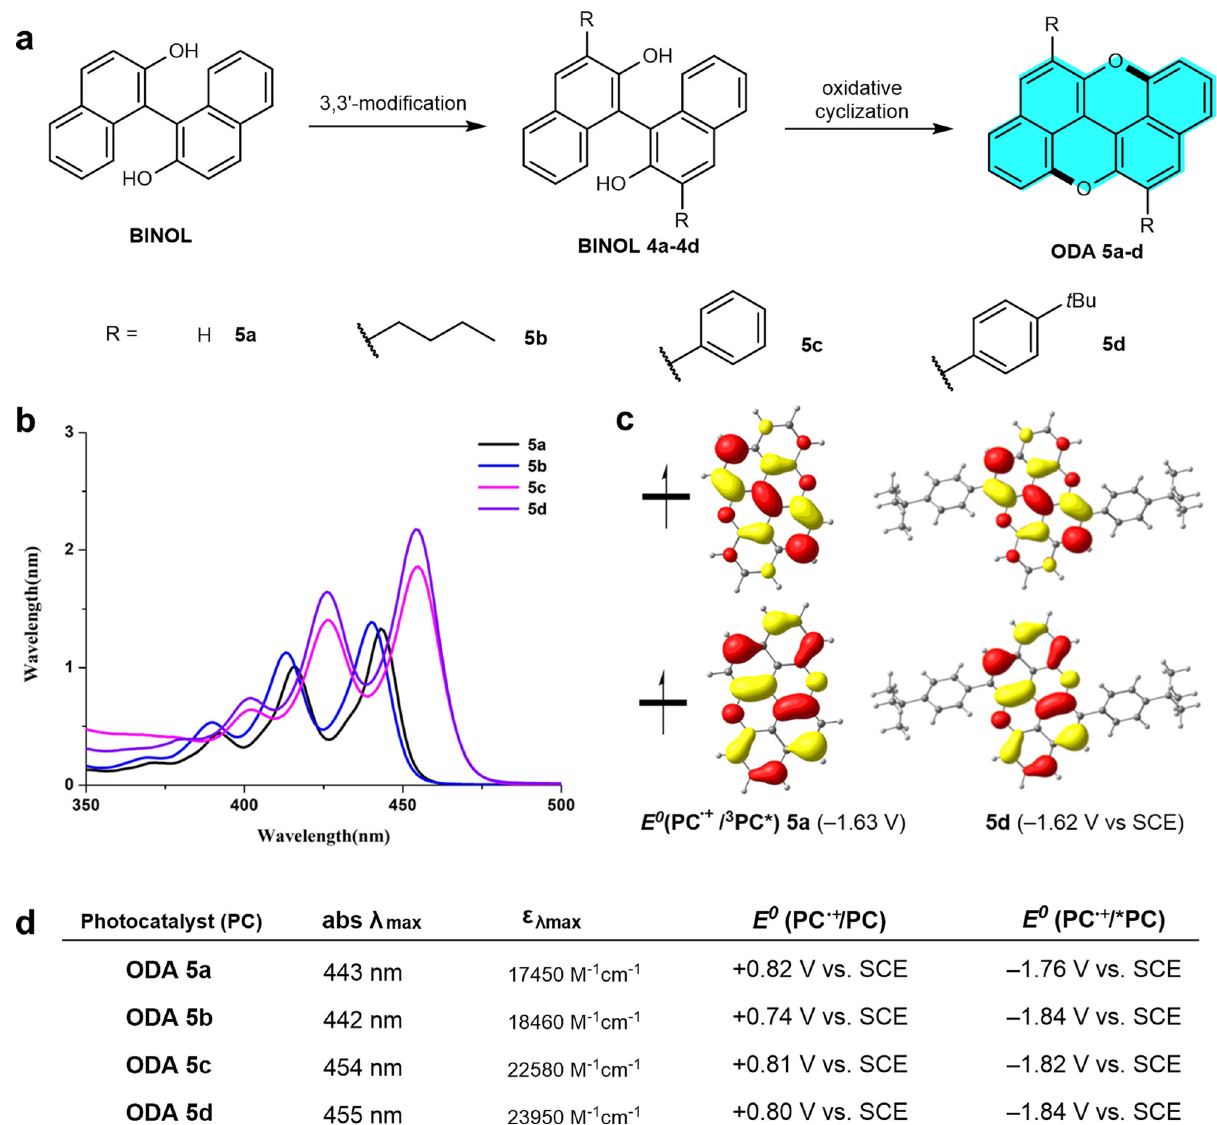
Fig. 2 Synthesis and characterization of photocatalysts. a Synthesis of oxygen-dopants of anthanthrene 5a – d . b UV-Vis absorption pro fi les. c SOMO orbitals and triplet reducing power of 5a and 5d . d Characterization data of photocatalyst 5a – 5d by UV-Vis, fl uorescence emission, CV, and calculated redox potentials. SCE s aturated calomel electrode, SOMO singly occupied molecular orbital, CV